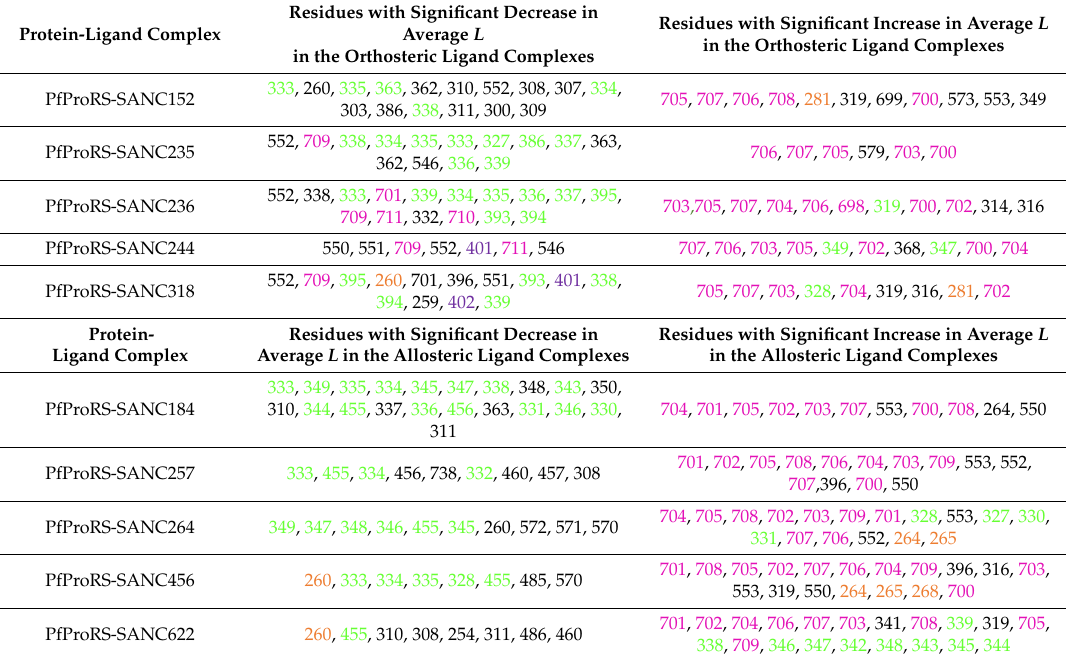
Table 4. Residues with significant changes in average L (2 standard deviations away). Residues at the active site are shown in green, residues at the ATP binding site in purple and residues at the Z-domain in